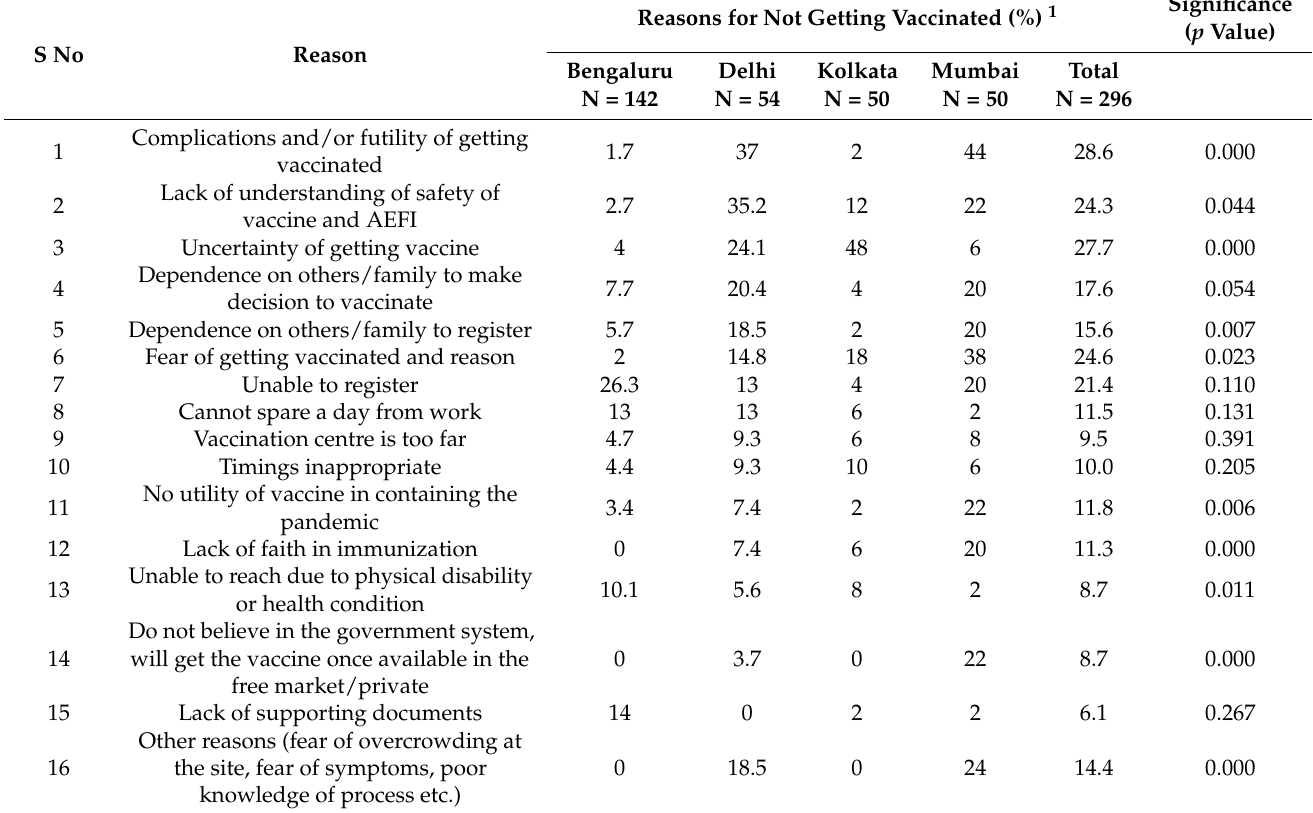
Table 7. Showing major reasons that influence vaccination